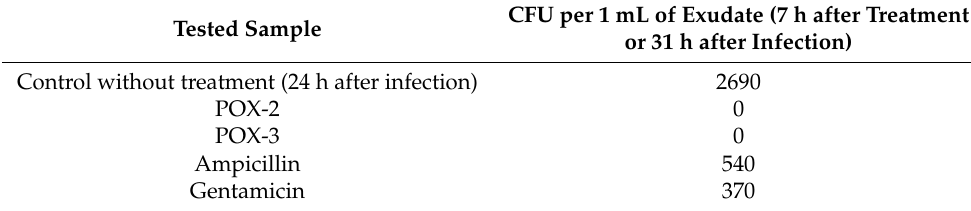
Table 3. In vivo antibacterial effect. CFU per 1 mL of Exudate (7 h after Treatment Tested Sample or 31 h after Infection) Control without treatment (24 h after infection)